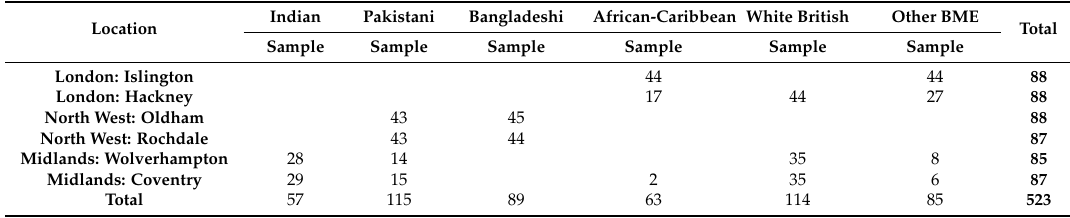
Table A1. Sample distribution by geographic location and ethnicity.